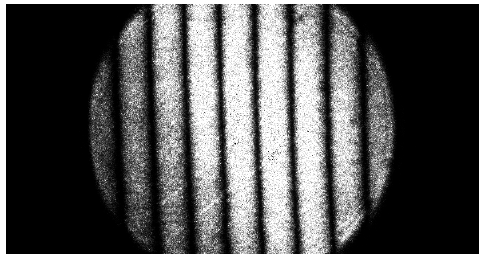
Figure 8. Actual interferogram.